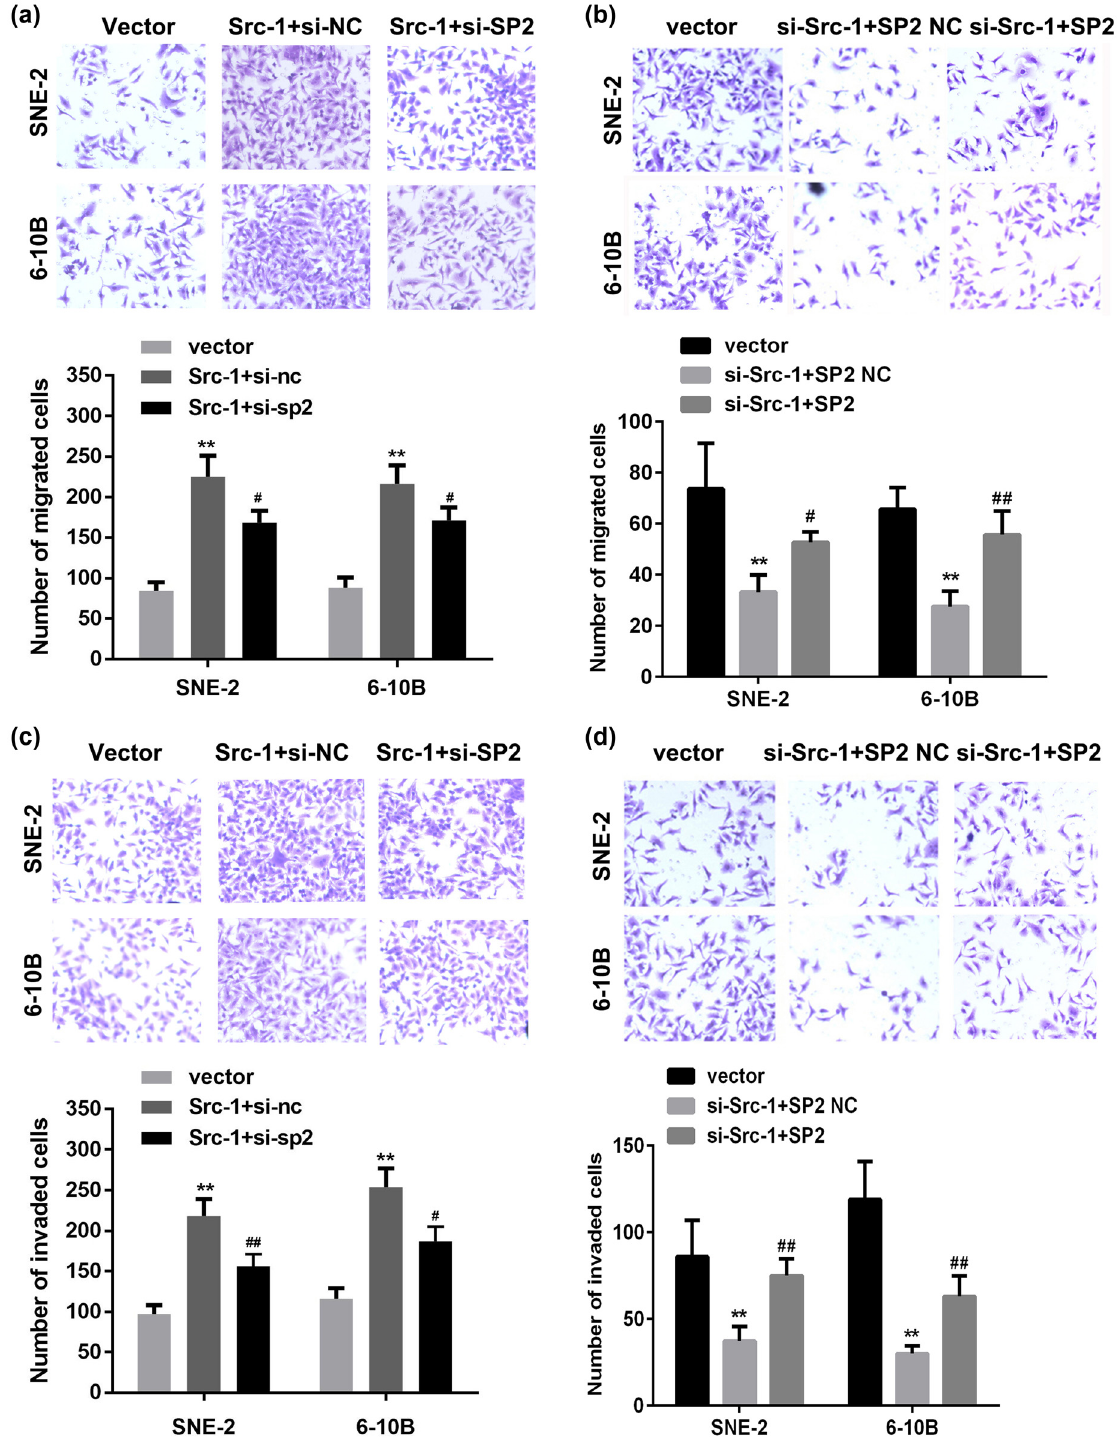
Figure 3: ( a,b ) The migration ability of NPC cells determined by transwell assay. ( c,d ) The invasion ability of NPC cells detected by transwell assay. ** P < 0.01 vs. Vector group. # P < 0.05, ## P < 0.01. vs. Src - 1 + si - nc group or si - Src - 1 + SP2 NC